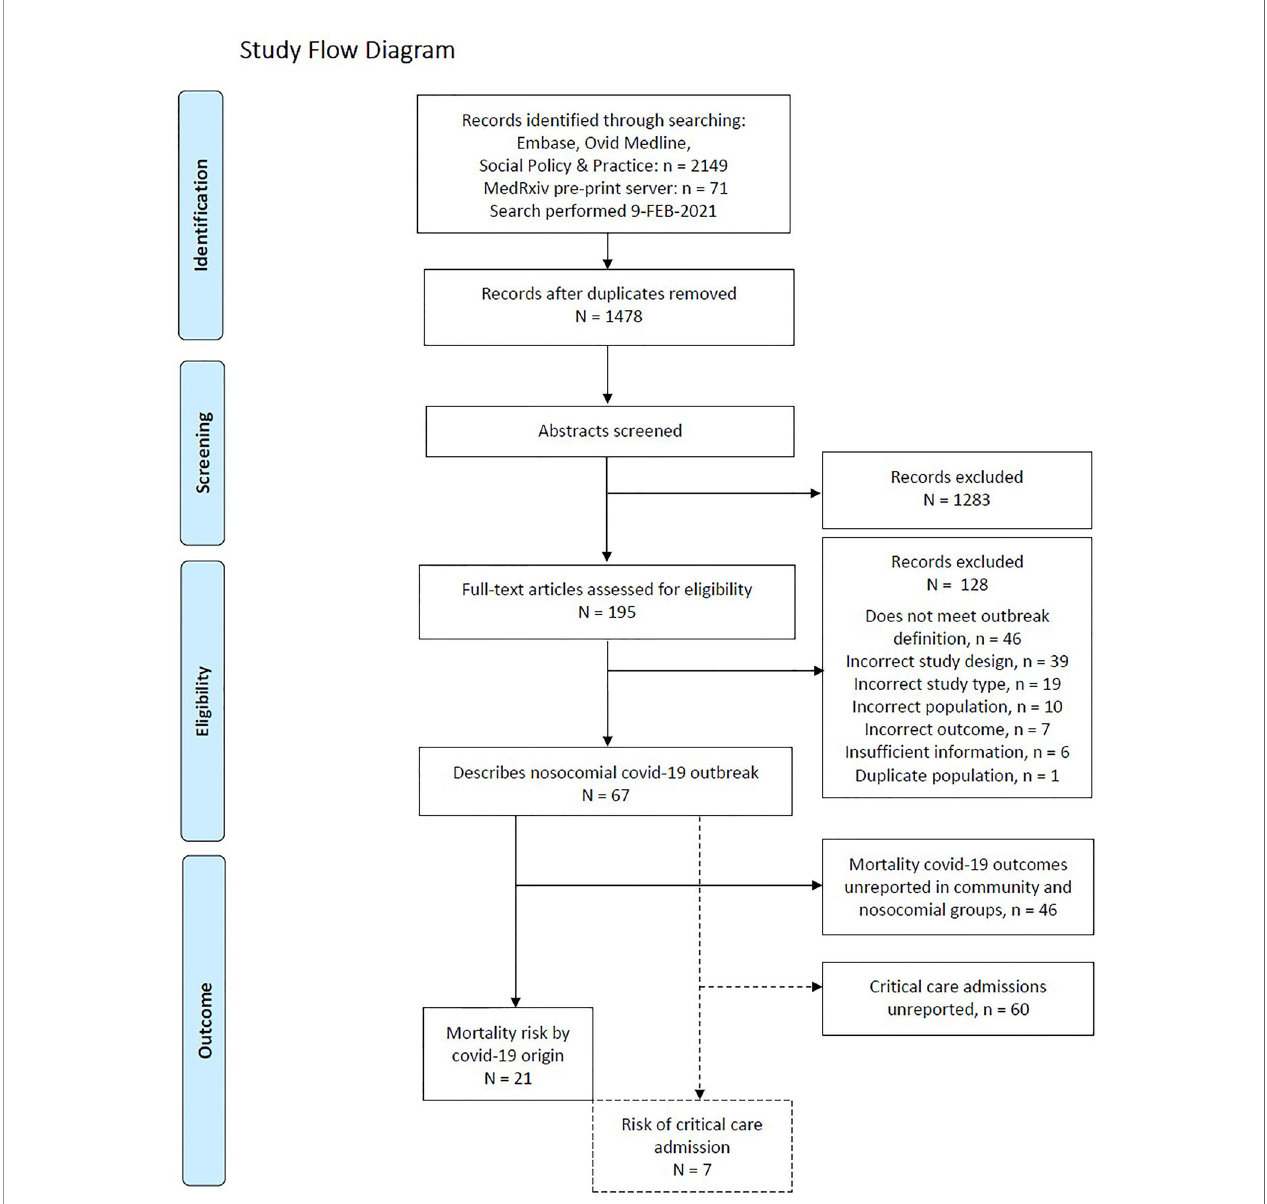
FIGURE 1 | PRISMA Study Flow